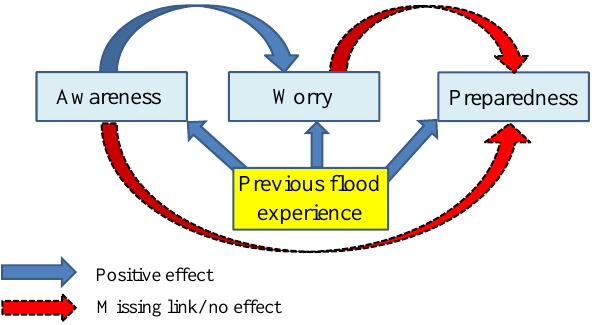
Fig. 4. Relationship between elements of risk perception in current